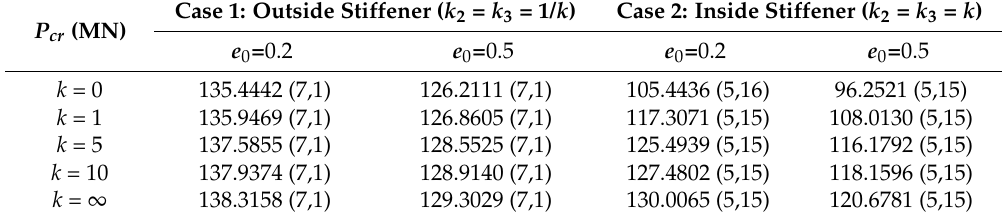
Table 8. Critical compression load P cr for different values of volume fraction indexes.